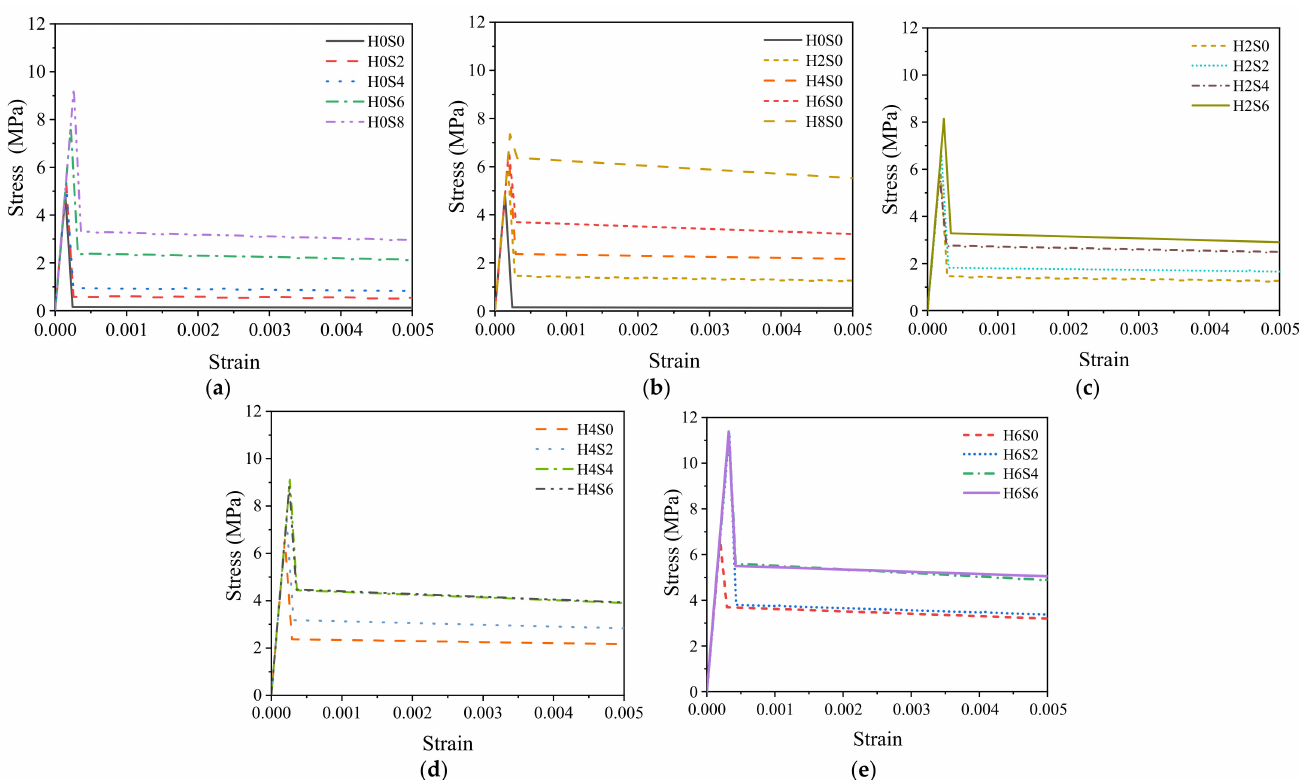
Figure 11. Tensile stress–strain curve. ( a ) Straight fiber—single; ( b ) End-hooked fiber—single; ( c ) 0.2% end-hooked fiber—hybrid; ( d ) 0.4% end-hooked fiber—hybrid; ( e ) 0.6% end-hooked